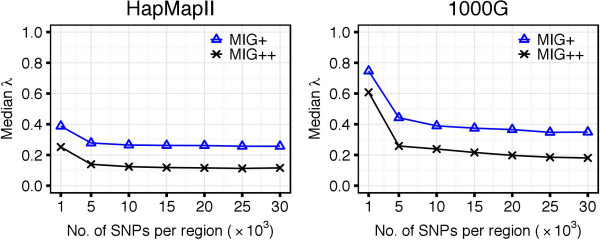
Values of the λ coefficient for MIG+ and MIG+ with the WP method. MIG + omits more SNP-pair weight computations than MIG +, which is reflected by the smaller λ coefficient.